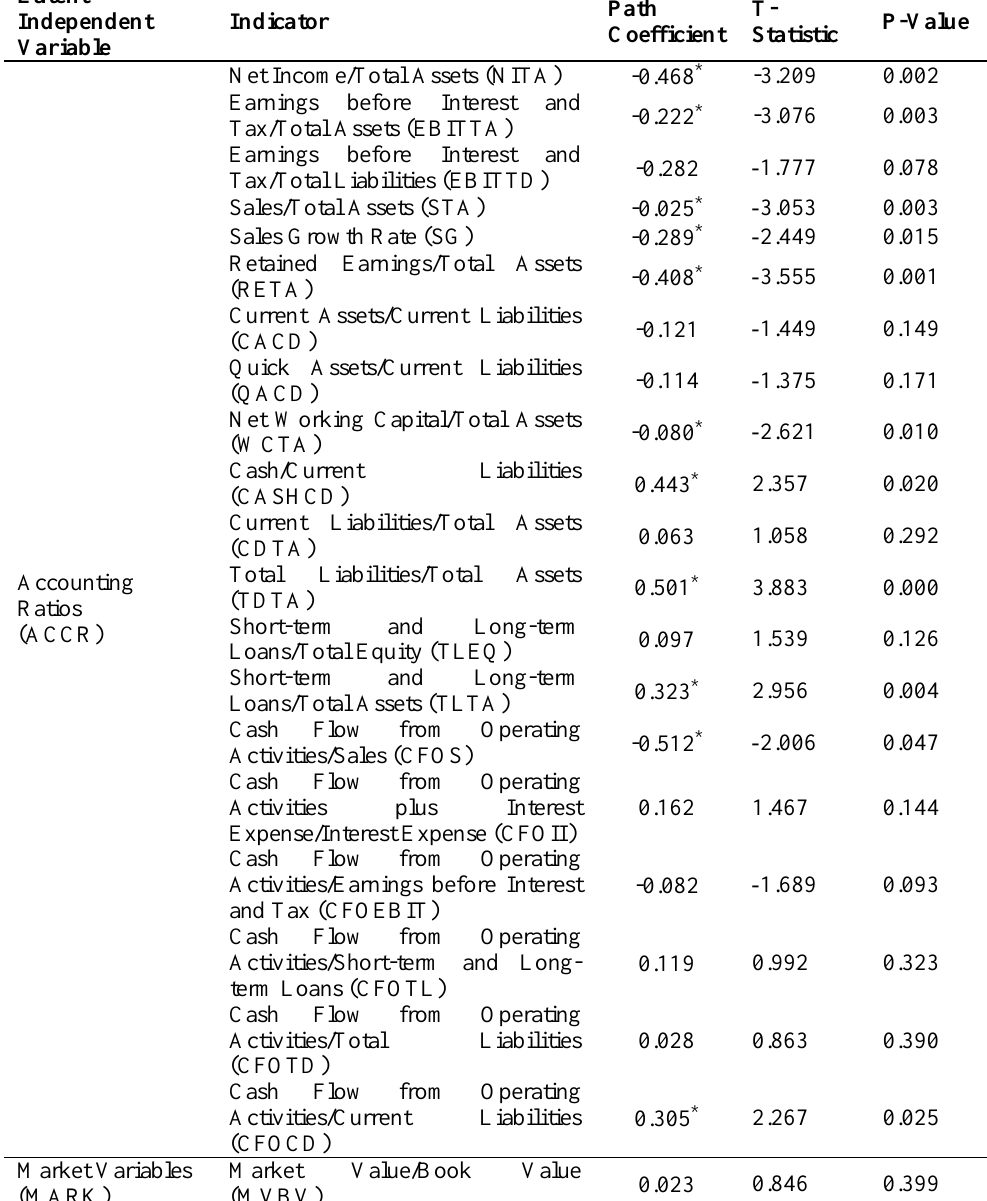
Table (15). Path Coefficient, T-Statistic and P-Value for Indicators